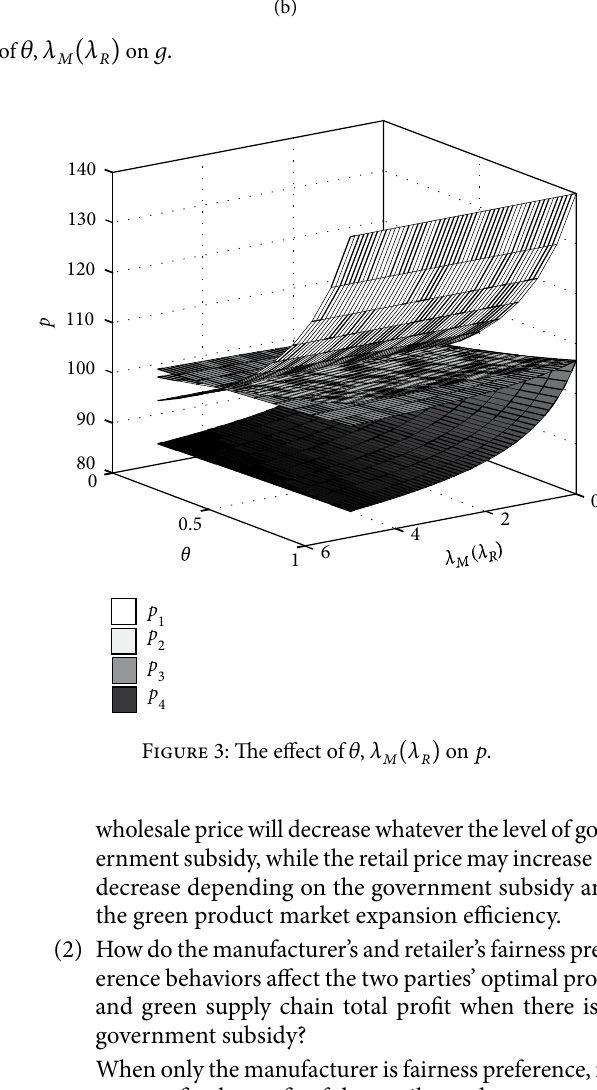
Figure 1: The effect of 𝜃 , 𝜆